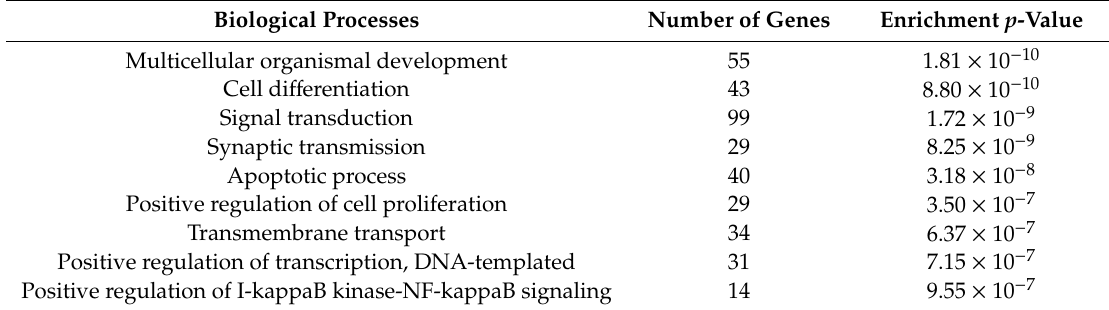
Table 1. The most representative biological processes based on enrichment p -values in ovarian